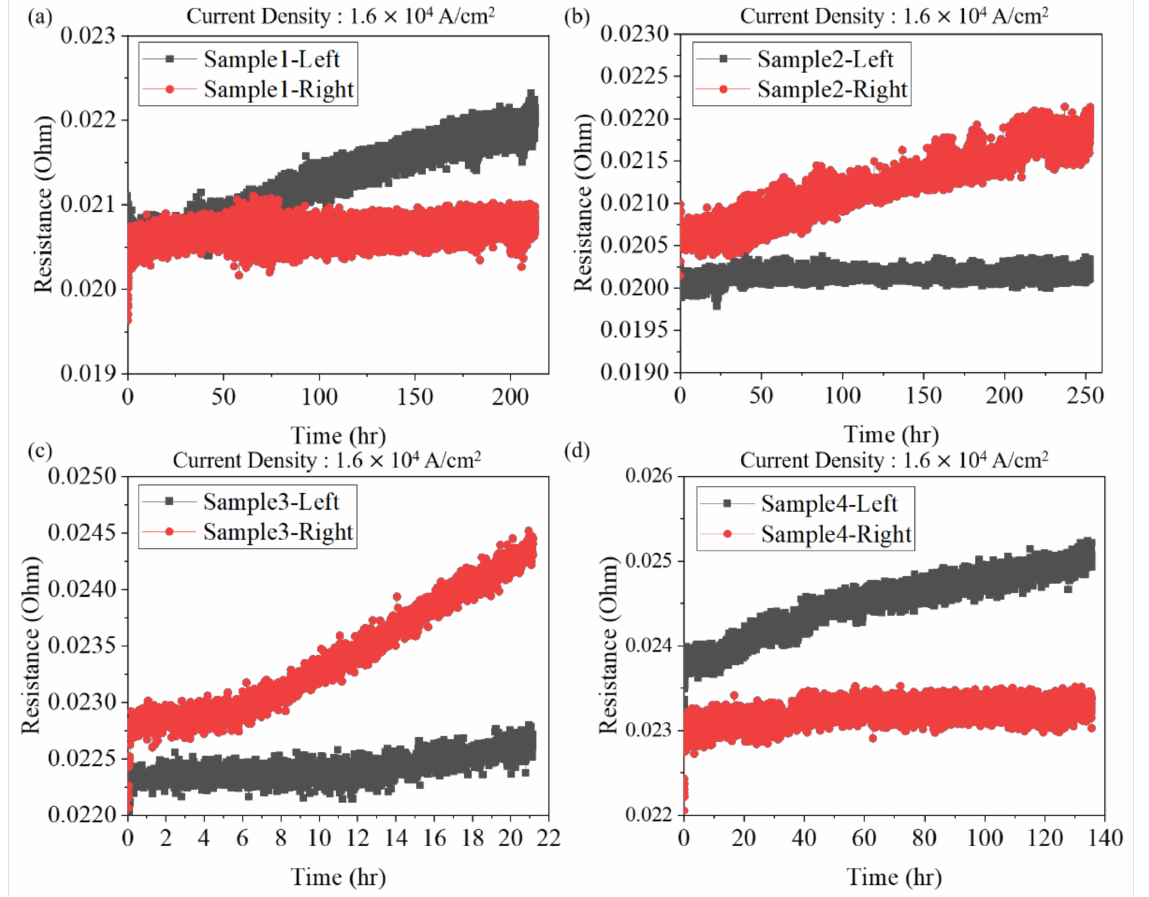
Figure 5. The resistance changes of ( a ) sample-1 ( b ) sample-2 ( c ) sample-3, and ( d ) sample-4 under a low current density.